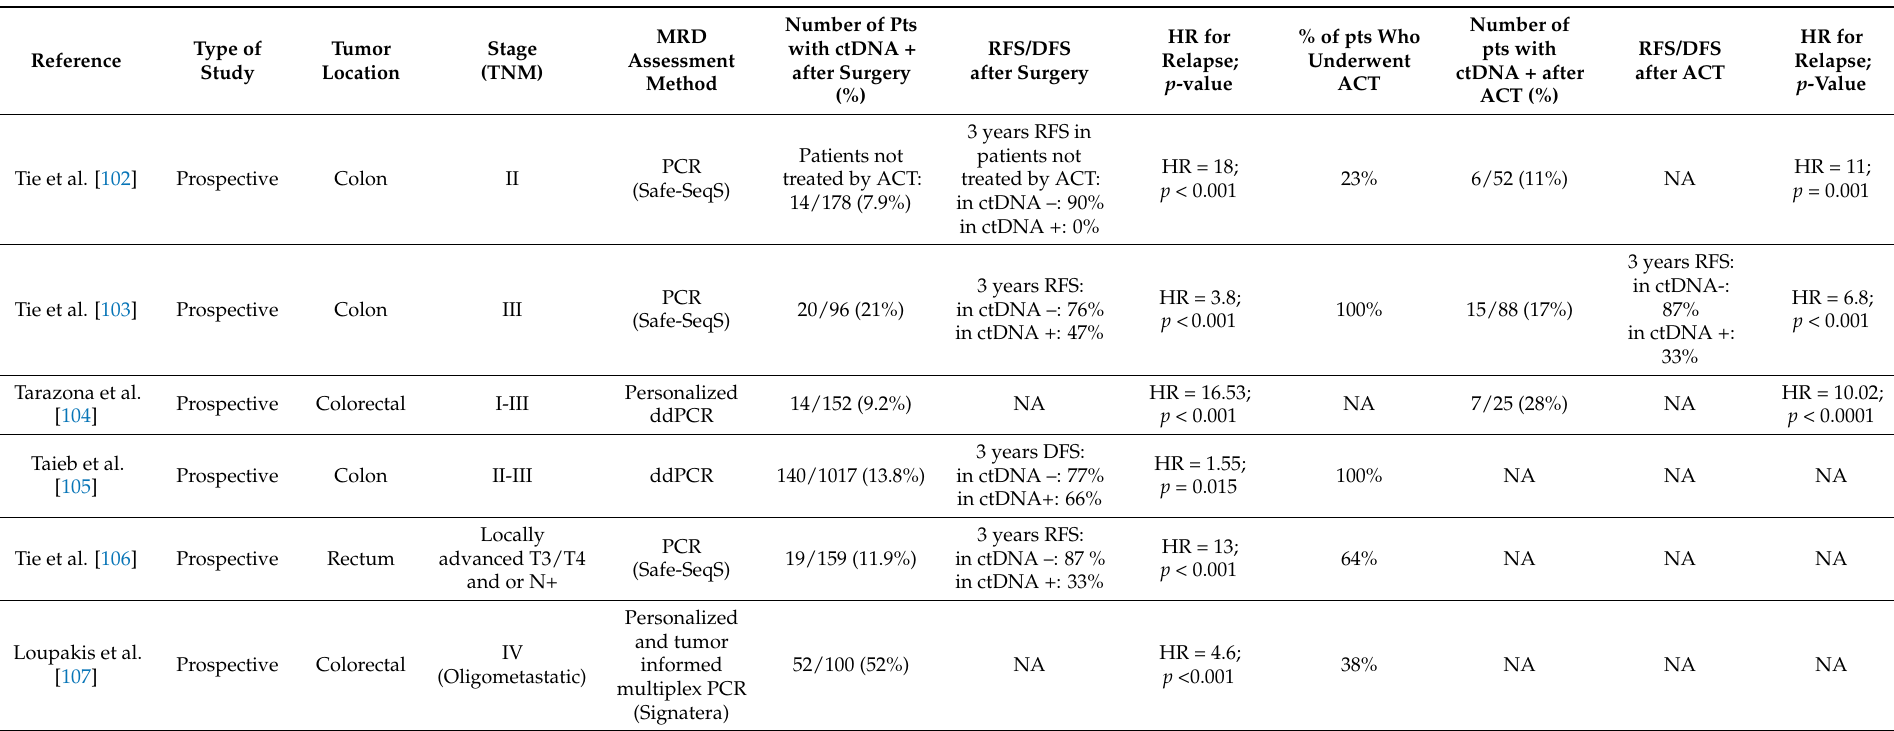
Table 1. Main Minimal Residual Disease assessment studies for circulating tumor DNA in colorectal